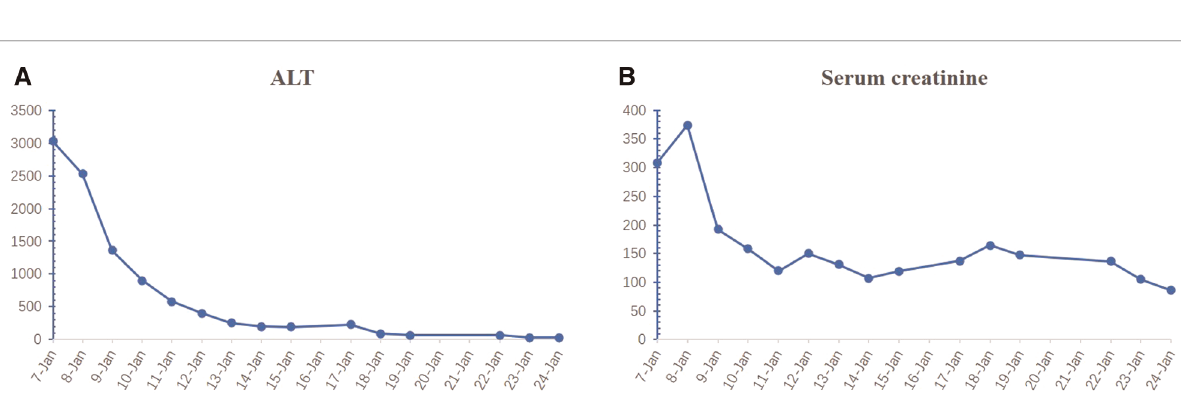
FIGURE 4 Changes in the ALT ( A ) and serum creatinine ( B ) levels over time. ALT, alanine